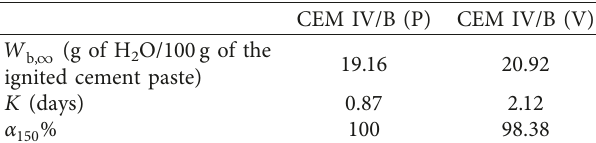
Figure 2: Correlation of experimental hydration data with (8). Table 4: Values of W , K , and α 150 % for the two types of cement b , pastes. ∞